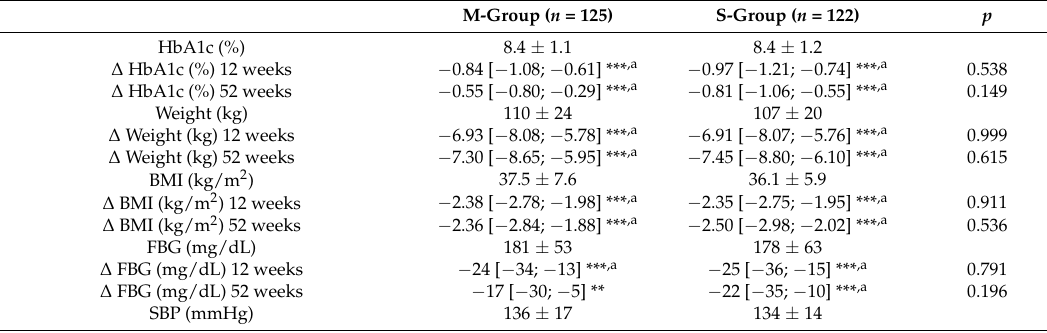
Table 3. Changes of anthropometric, clinical, pharmaceutical, and behavioral parameters (secondary